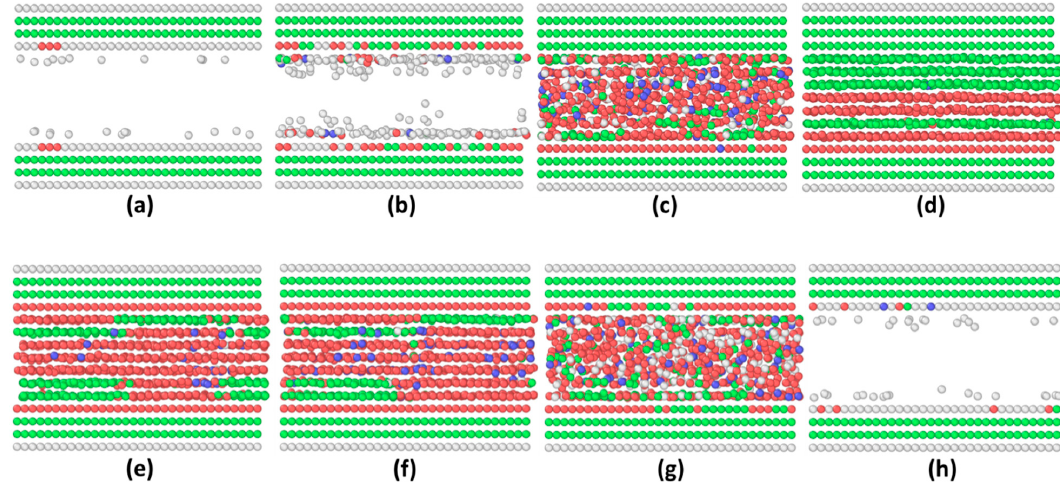
Figure 4. The snapshots of atomic configurations of adsorption-desorption isotherms for argon molecules confined between two commensurate contacts at 85 K for n = 7 monolayer thickness. Adsorption: ( a ) μ = − 2.40 kcal/mol, ( b ) μ = − 2.23 kcal/mol, ( c ) μ = − 2.225 kcal/mol, and ( d ) μ = − 2.19 kcal/mol. Desorption: ( e ) μ = − 2.15 kcal/mol, ( f ) μ = − 2.32 kcal/mol, ( g ) μ = − 2.325 kcal/mol, and ( h ) μ = − 2.40 kcal/mol.